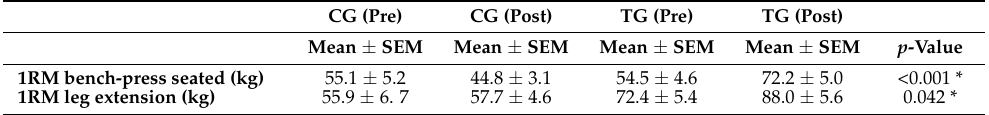
Table 2. Effect of an 8-week resistance training in muscular strength.